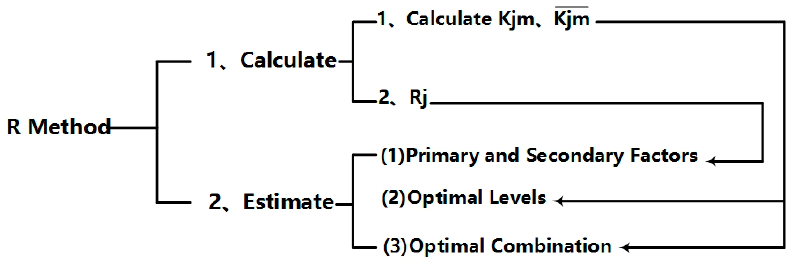
Figure 1. Schematic diagram of range analysis content.